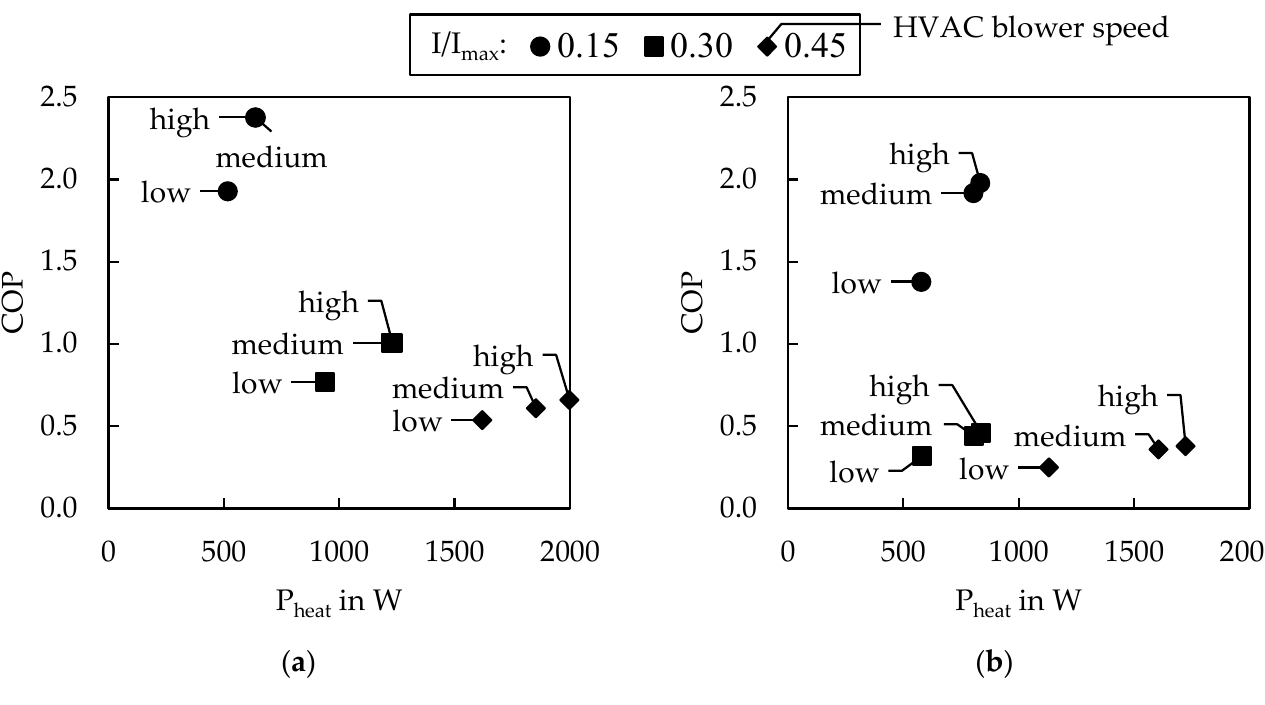
Figure 11. Measurement results showing coefficient of performance over-heating power: ( a ) with pre-conditioned coolant loop; ( b ) without pre-conditioned coolant loop. Measurement results taken from [43].